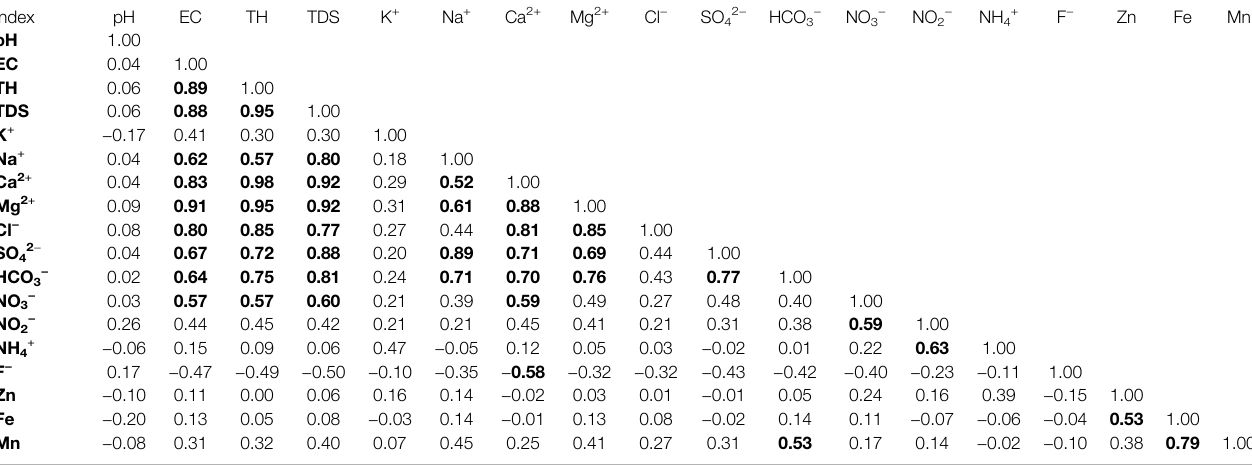
TABLE 3 | The correlation matrix between various hydrochemical parameters of phreatic groundwater in the study area.